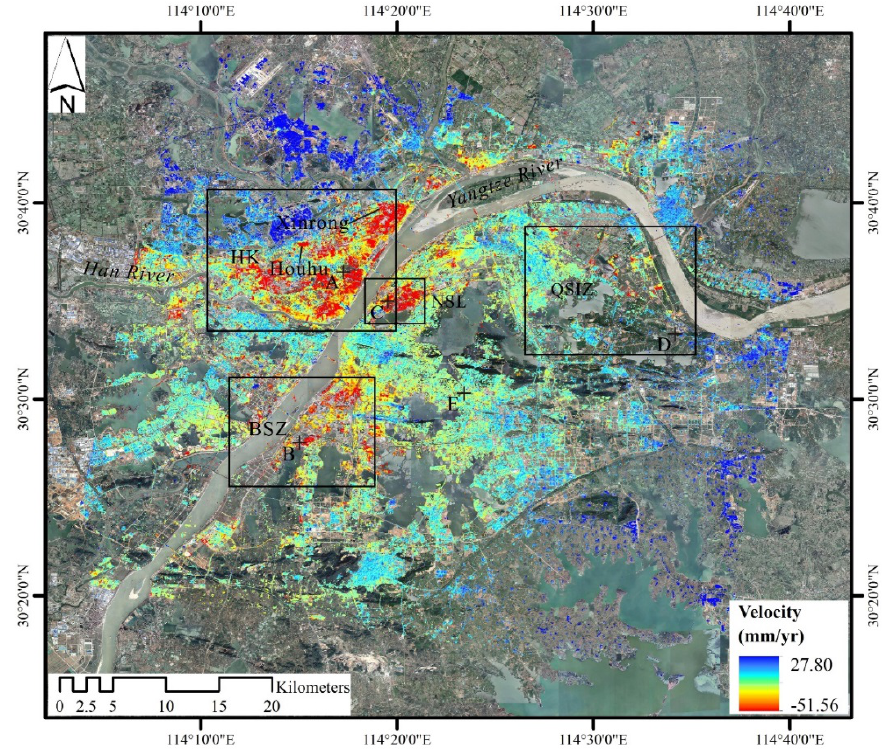
Figure 4. The average subsidence velocity in LOS from October 2015 to June 2018 across Wuhan city by using SBAS-InSAR technique. The four black rectangles are the four major areas of subsidence. A-E are five points of subsidence, detailed in Figure 6.